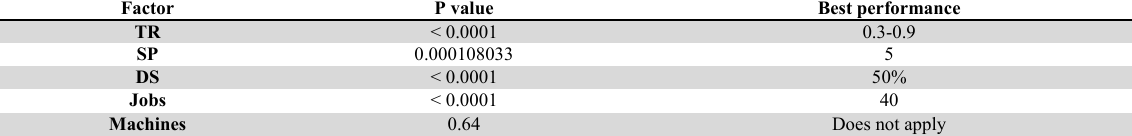
ANOVA-Type Statistic Results by individual factor of improvement of GA vs Dispatching